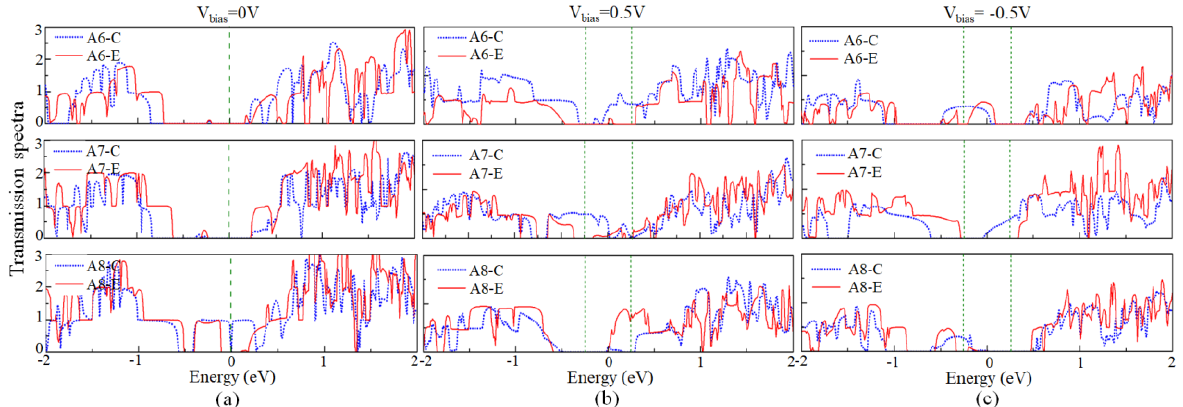
Figure 5. The transmission spectra of AA-P 2 -doped ASiNR devices with widths of 6, 7, and 8 under different biases (N = 6, 7, and 8); ( a – c ) correspond with V b = 0 V, 0.5 V, and − 0.5 V, respectively. The vertical green dashed lines indicate the bias window.